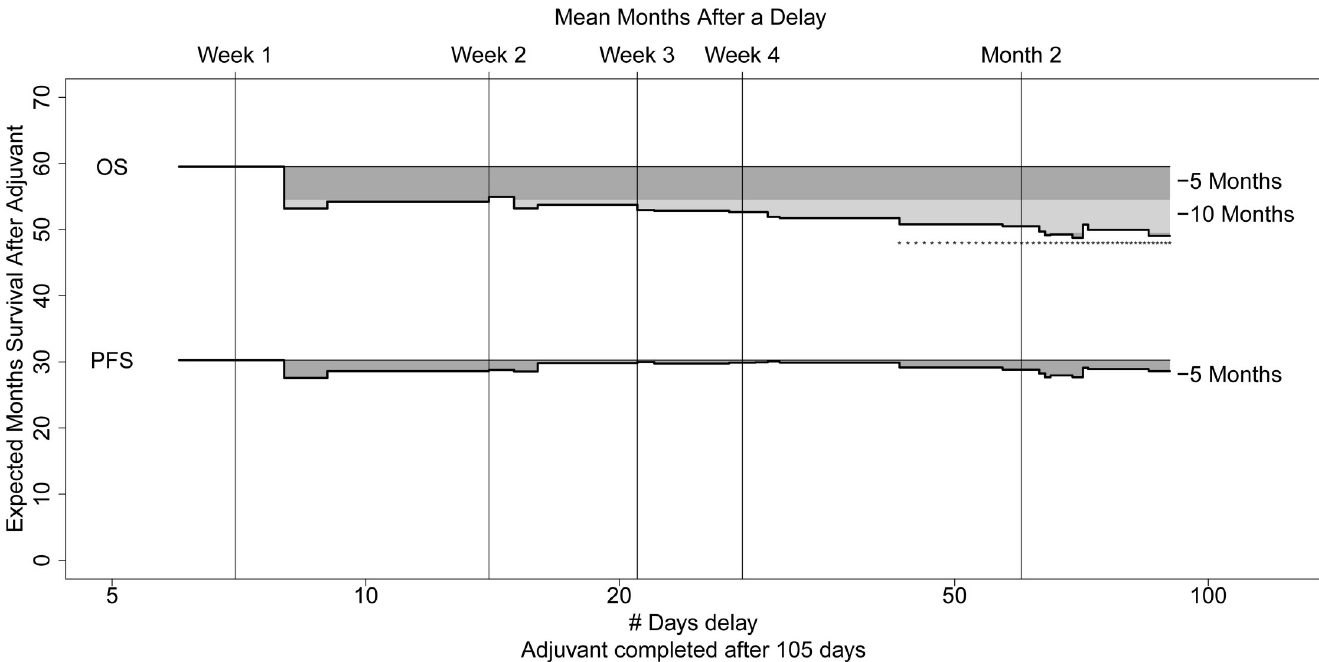
Fig 4. Delay sub-study: Effect of delays on survival by week in women receiving Carboplatin/Paclitaxel adjuvant chemotherapy with duration � 105 days.